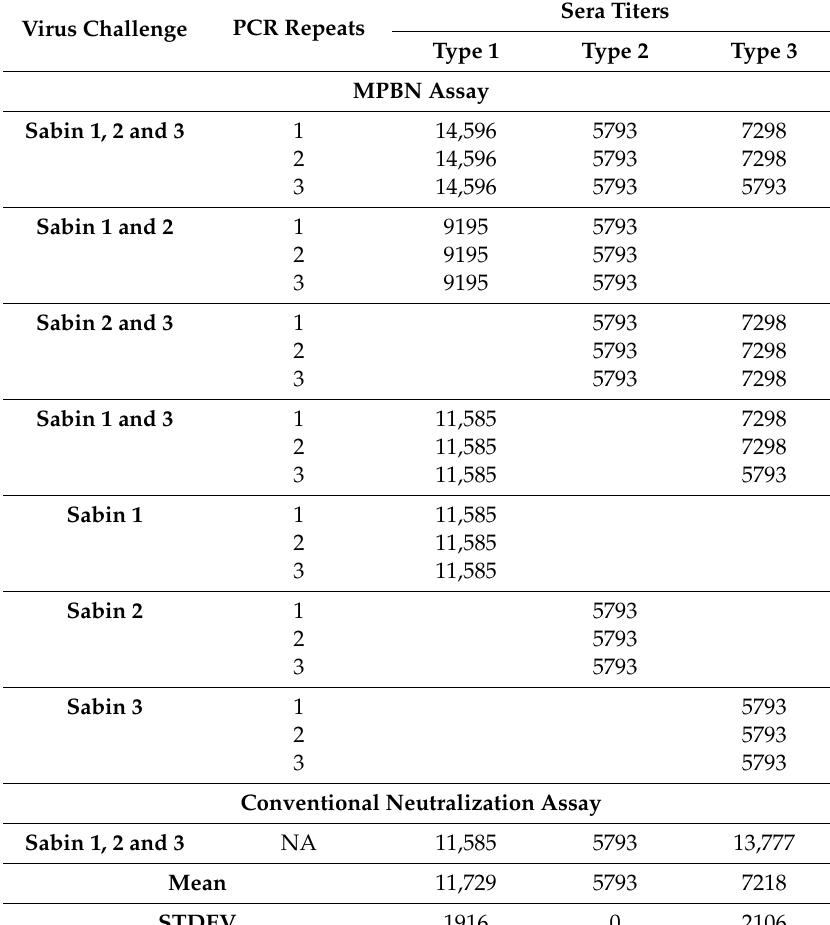
Table 2. Titration of human anti-poliovirus sera type 1, 2 and 3 with multiplex PCR-based neutralization (MPBN) and conventional neutralization